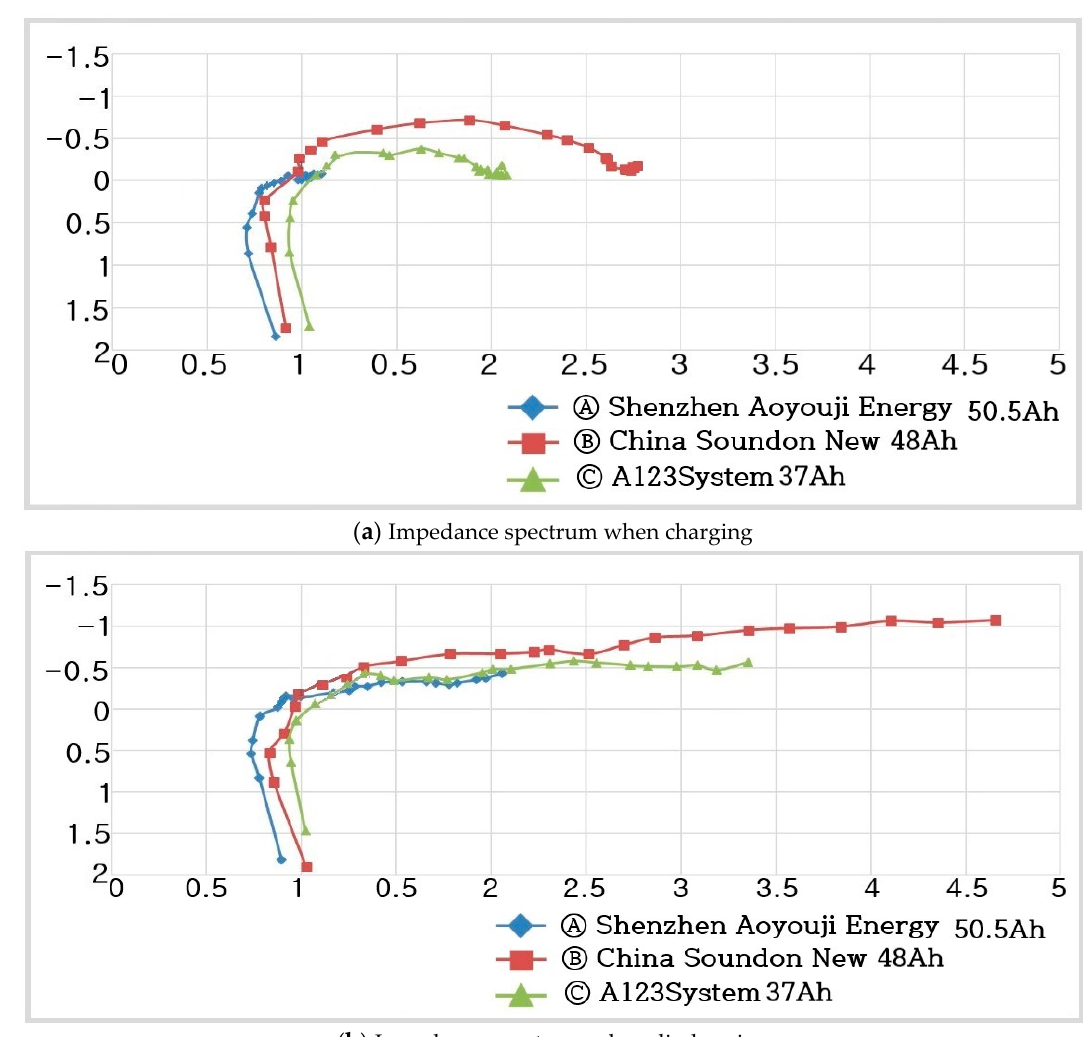
Figure 22. Impedance spectra of cylindrical Li-ion batteries.